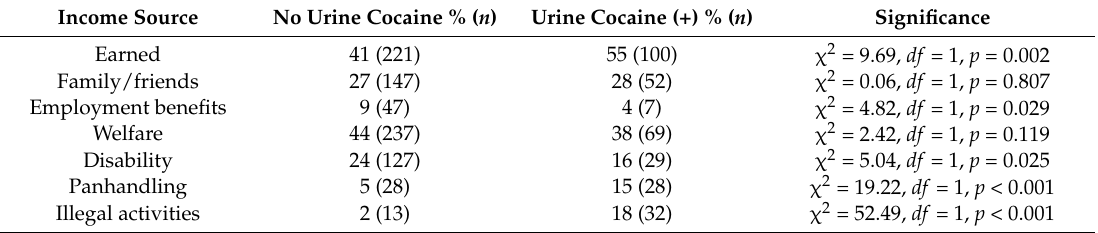
Table 6. Proportions with 30-day income sources among those with and without 30-day drug expenditures in the same month.